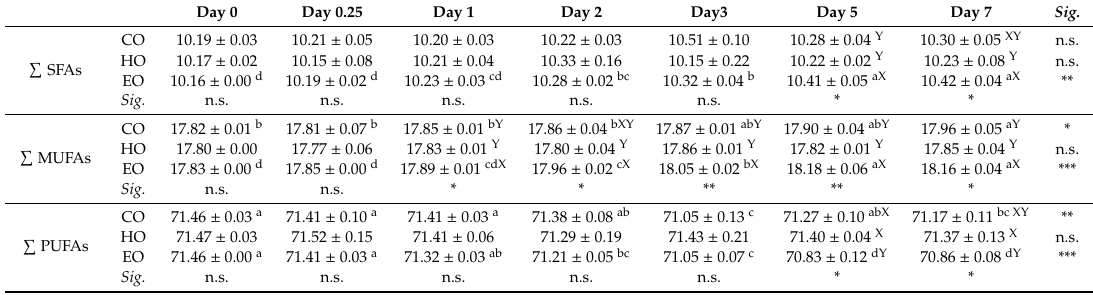
Results are reported as mean ± standard deviation ( n = 3). Means followed by the same lowercase (row; within the sample, among the days) letters a–d and uppercase (column; within the day, among the samples) letters X,Y are not significantly di ff erent at p < 0.05 (Duncan’s test). n.s. = not significant; * = p < 0.05; ** = p < 0.01; *** = p <